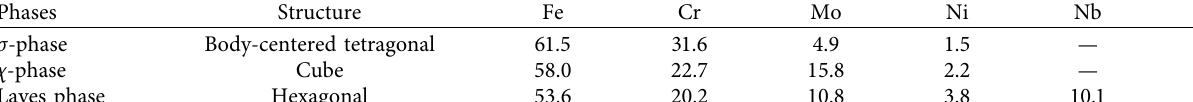
Table 1: The main element content and the structure of intermediate phases in SFSS(wt%) [25].